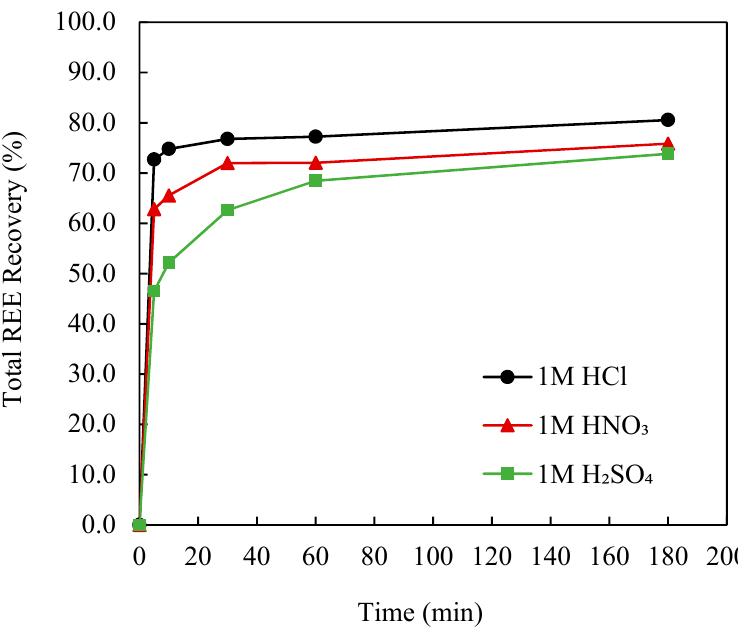
Figure 5. Effect of acid type on the leaching recovery of total rare earth elements contained in the Fire Clay coal middlings (75 °C, 530 rpm, solid-to-liquid ratio (S/L) = 10 g/L, d 80 = 8.7 μ m).